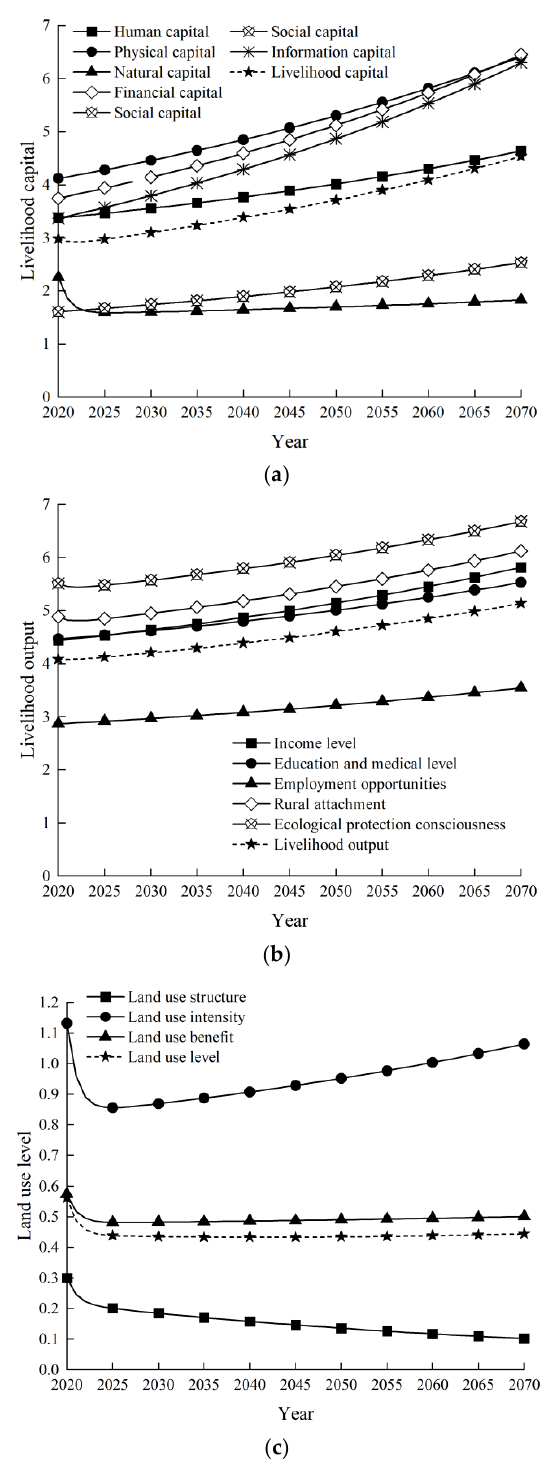
Figure 6. Changes in farmers' livelihood and land use under the basic scenario. ( a ) Livelihood capital; ( b ) Livelihood output; ( c ) Land use level. ( b ) Livelihood output; ( c ) Land use